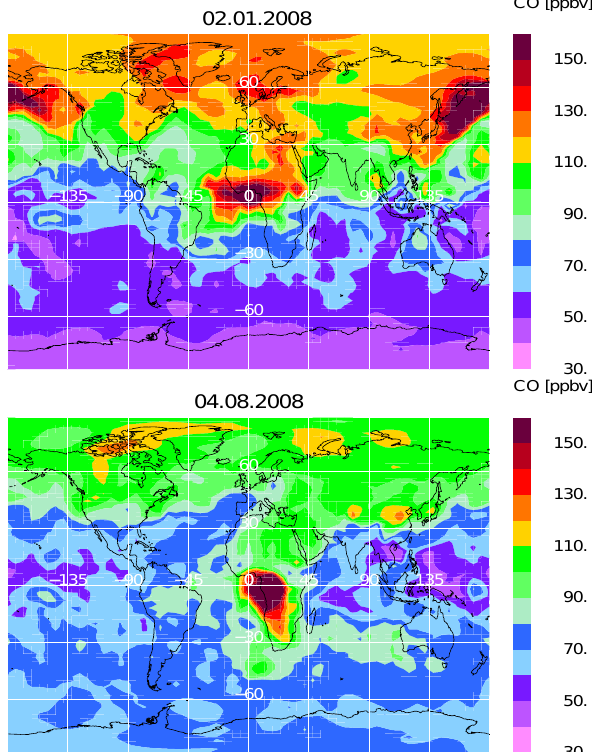
Figure 1. Mixing ratios of CO on the ζ = 200K model level ( ≈ 3– 4km) on 2 January 2008 (top panel) and 4 August 2008 (bottom panel), as derived from five days of MOPITT (version 4) measure- ments through a trajectory technique. (See text for